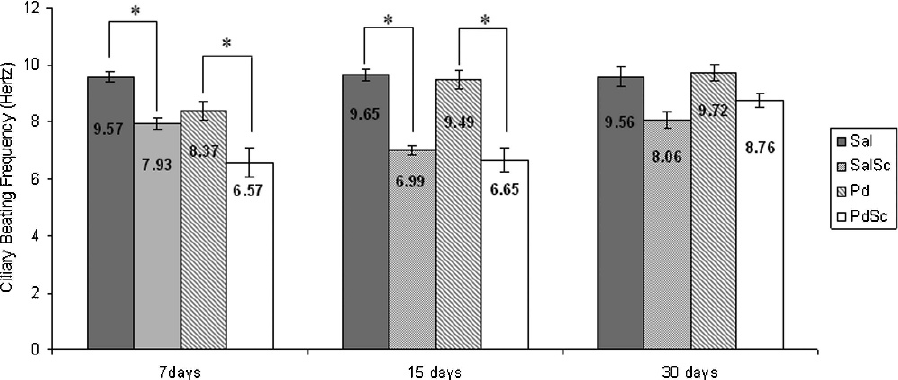
Figure 1 - The ciliary beat frequency (mean ¡ standard deviation) of animals undergoing or not undergoing bronchial section and anastomosis and treated with prednisone or saline solution for 7, 15, or 30 days. Animals undergoing the surgical procedure had a significant CBF decrease at 7 and 15 days after the surgical procedure ( p , 0.001).